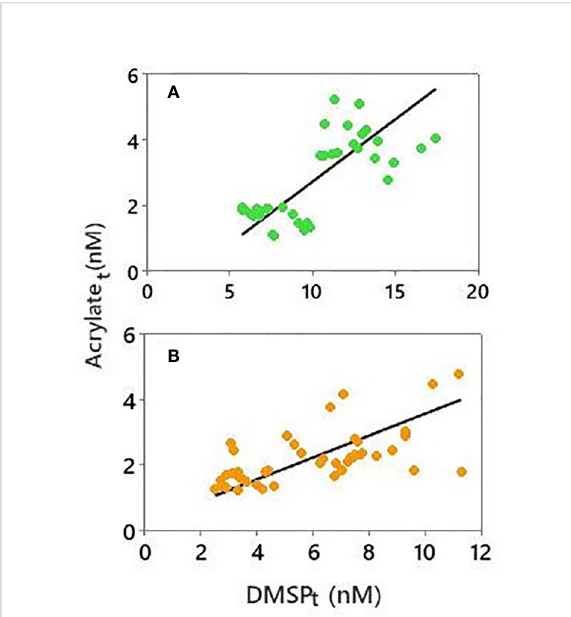
FIGURE 3 Correlation between acrylate t and DMSP t in samples collected between 4 and 27 April from the (A) oceanic stations (SO and OO) and (B) coral reef (CH, BR, CR). Solid lines denote the best- fi t from orthogonal regression analysis: (A) slope = 0.38 ± 0.06, y-intercept = -1.08 ± 0.60 nM, r = 0.75; (B) slope = 0.33 ± 0.06, y-intercept = 0.24 ± 0.41 nM, r =